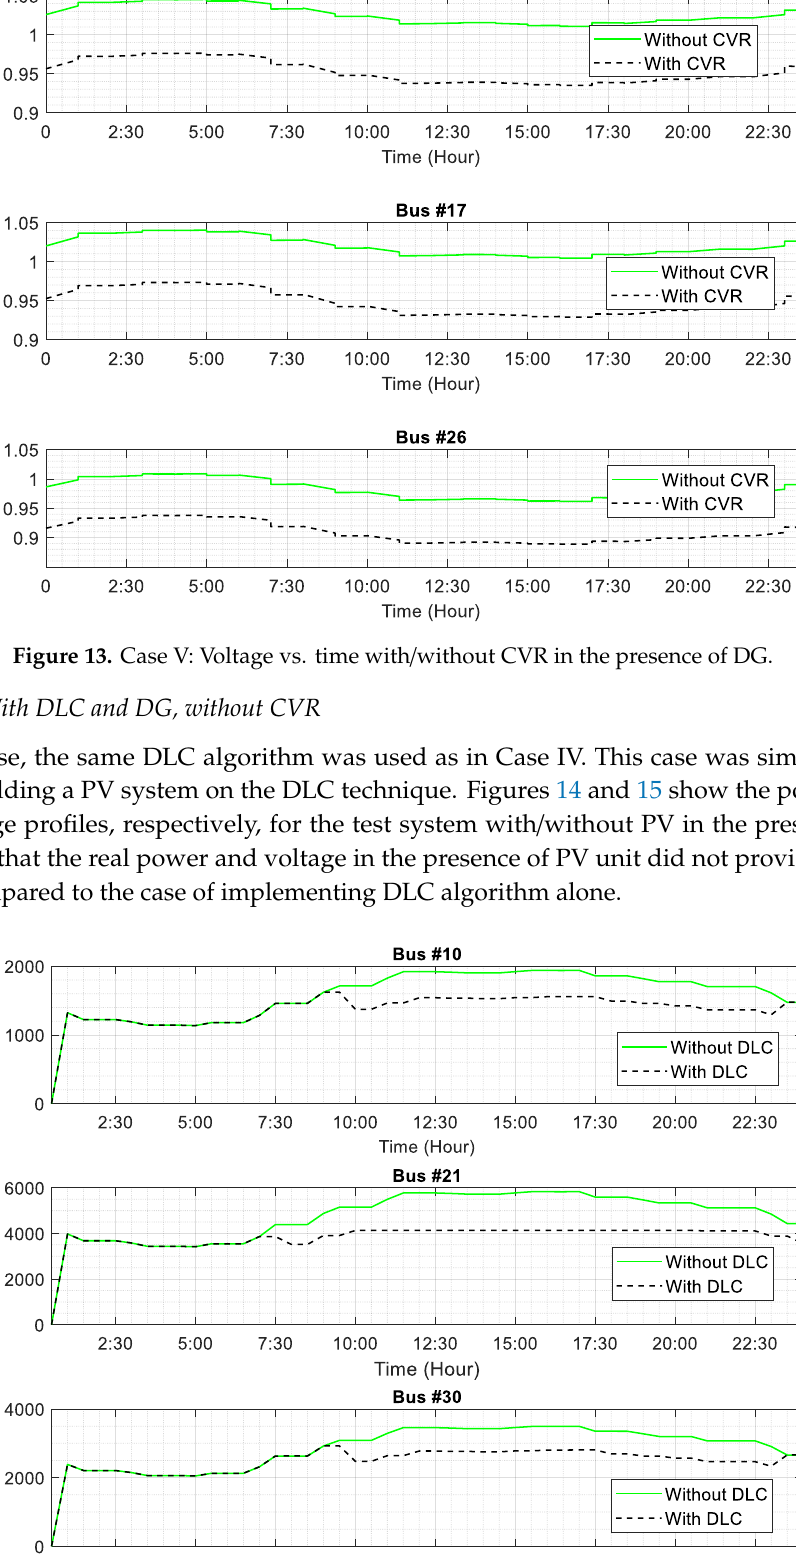
Figure 15. Case VI: Voltage profile with/without DLC in the presence of DG. The active power and active power reduction with/without DLC in the presence of DG are evaluated for the concerned buses; the results are summarized in Table 7. As in Case V, the effect the DG had on the DSM technique (DLC) is a slightly non-positive one. The DG lowered the saved